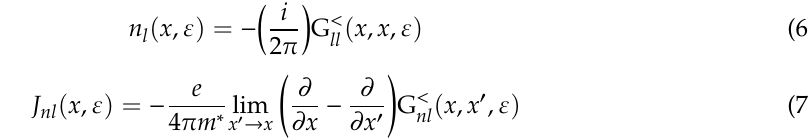
Figure 3. Local density of states (LDOS) along the nanowire axis. The dashed line depicts the first sub-band edge. Dark red indicates high LDOS and dark blue low LDOS. The drain bias is 0.6 V and the gate bias is 0.2 V.